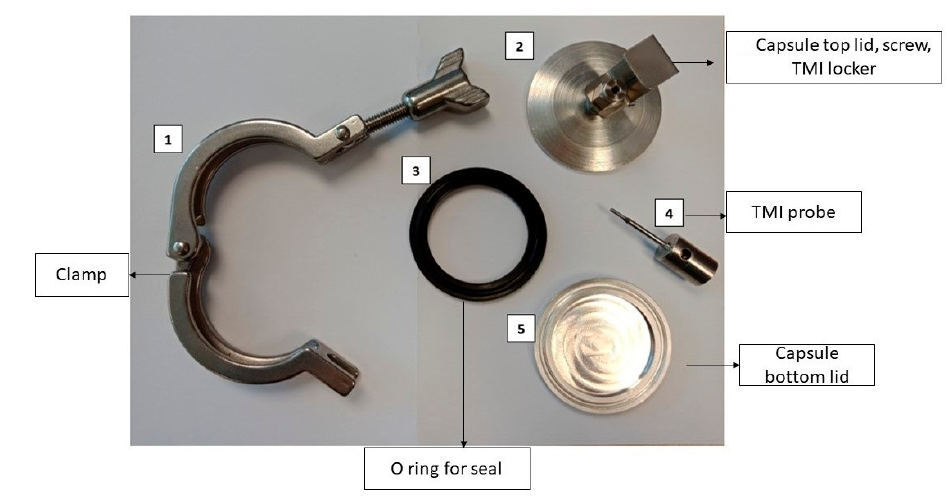
Figure 4. Capsule set up for the oil bath work with the main parts.